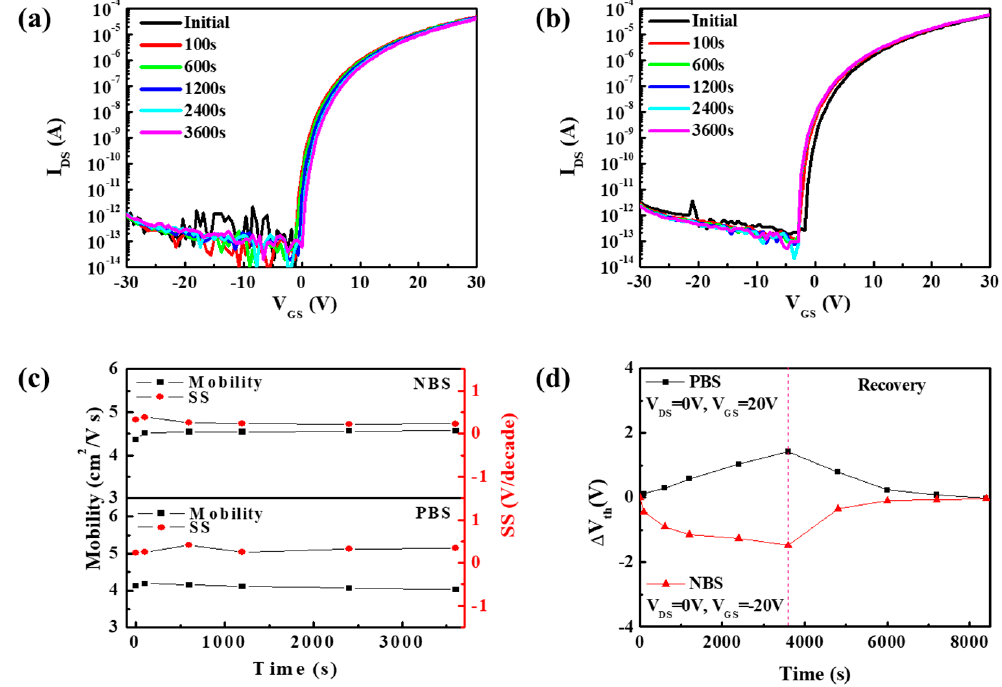
Figure 6. The evolution of transfer characteristic curves of device C annealed at 450 °C in vacuum argon ambient under ( a ) dark PBS condition and ( b ) dark NBS condition. ( c ) The change of mobility and SS of device C as a function of stress time under PBS condition and NBS condition. ( d ) Variation in the V th value as a function of stress time and recovery time. The pink dash line is at the position of 3600 s.